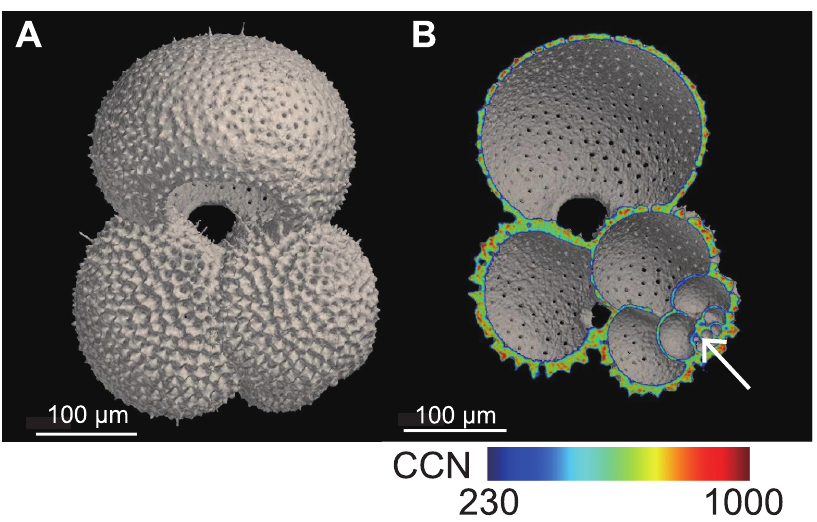
Fig 4. Three-dimensional tomograms of the shell of a Globigerinoides ruber specimen (ID #1 in Table 1). Tomogram of the exterior (4A). CT cross-section image of the same shell with coloring according to calcite density (4B). The white arrow marks the first chamber. Planktic foraminifers secrete calcite and grow chamber by chamber.